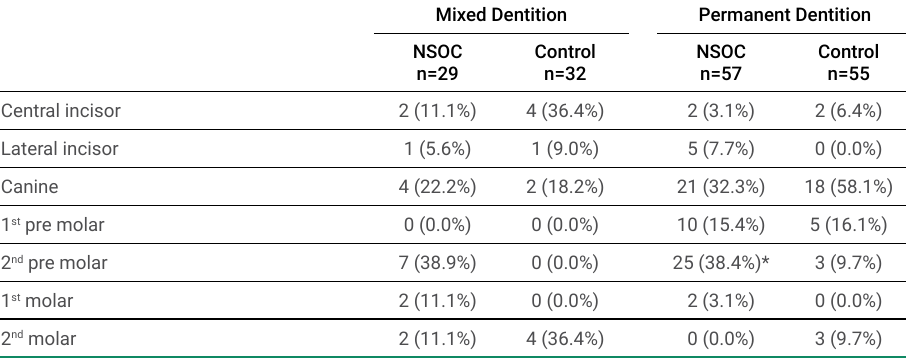
Table 3. Number of dental anomalies in mixed and permanent dentition in the nonsyndromic oral cleft and control